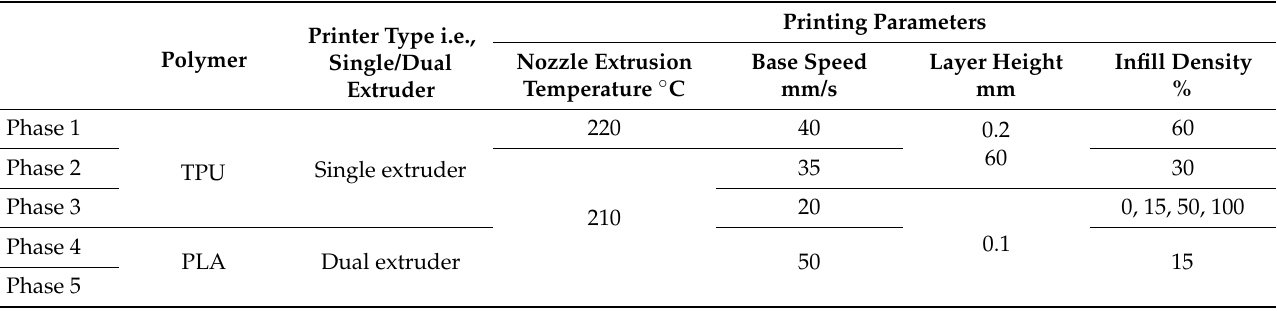
Table 1. Summary of printing phases, polymers used, printer type (i.e., single or dual extruder), and printing parameters.